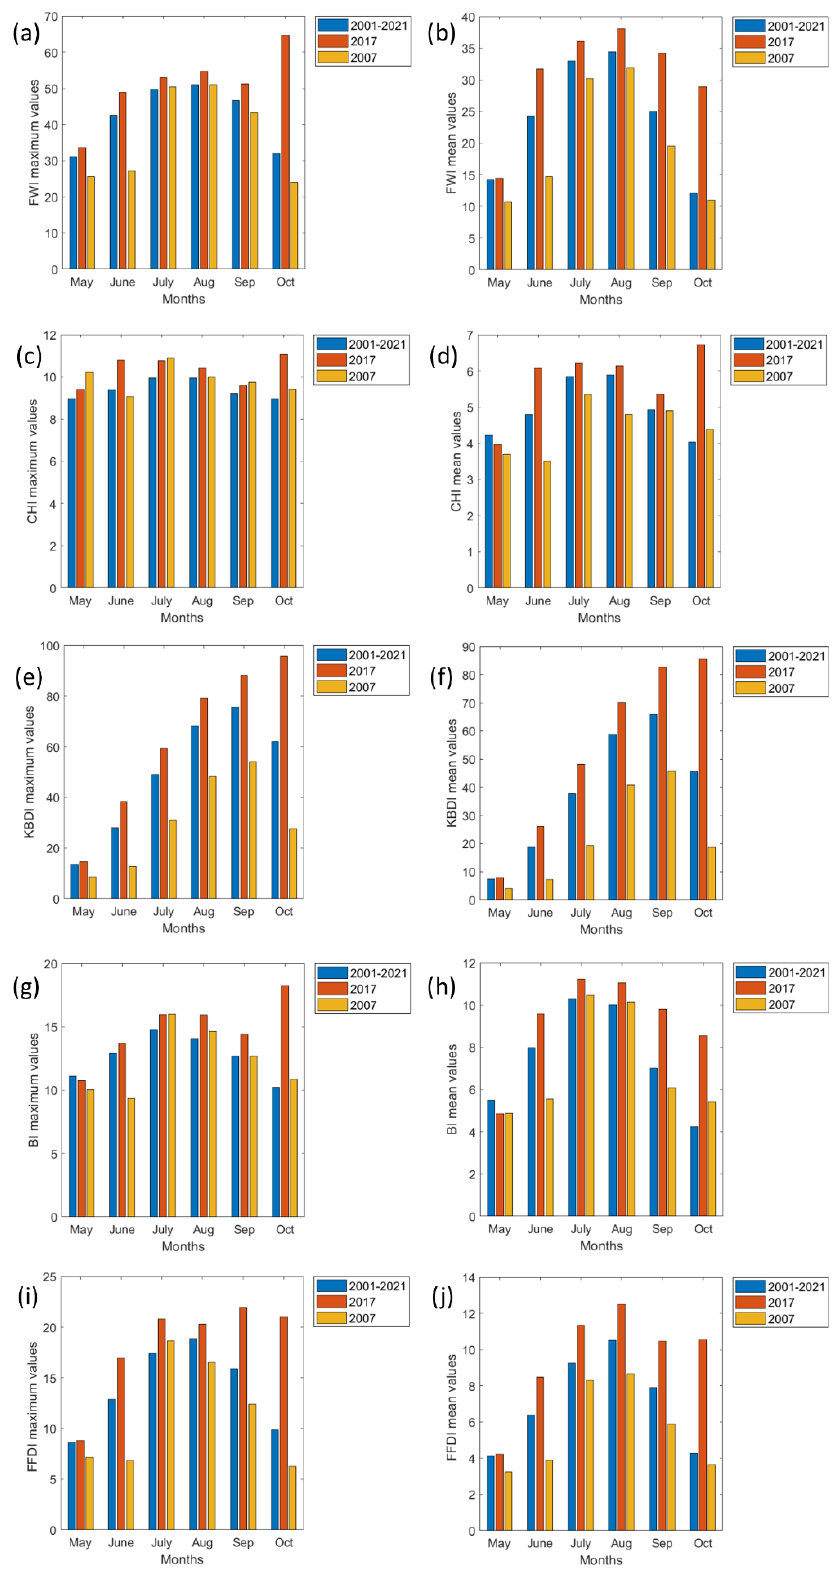
Figure A4. Monthly average values between 2001–2021 (baseline climate),2017, and 2007 for ( a , b ) FWI, ( c , d ) CHI, ( e , f ) KBDI, ( g , h ) BI, and ( i , j ) FFDI for the maximum (left) and mean (right) values, respectively, for mainland Portugal.